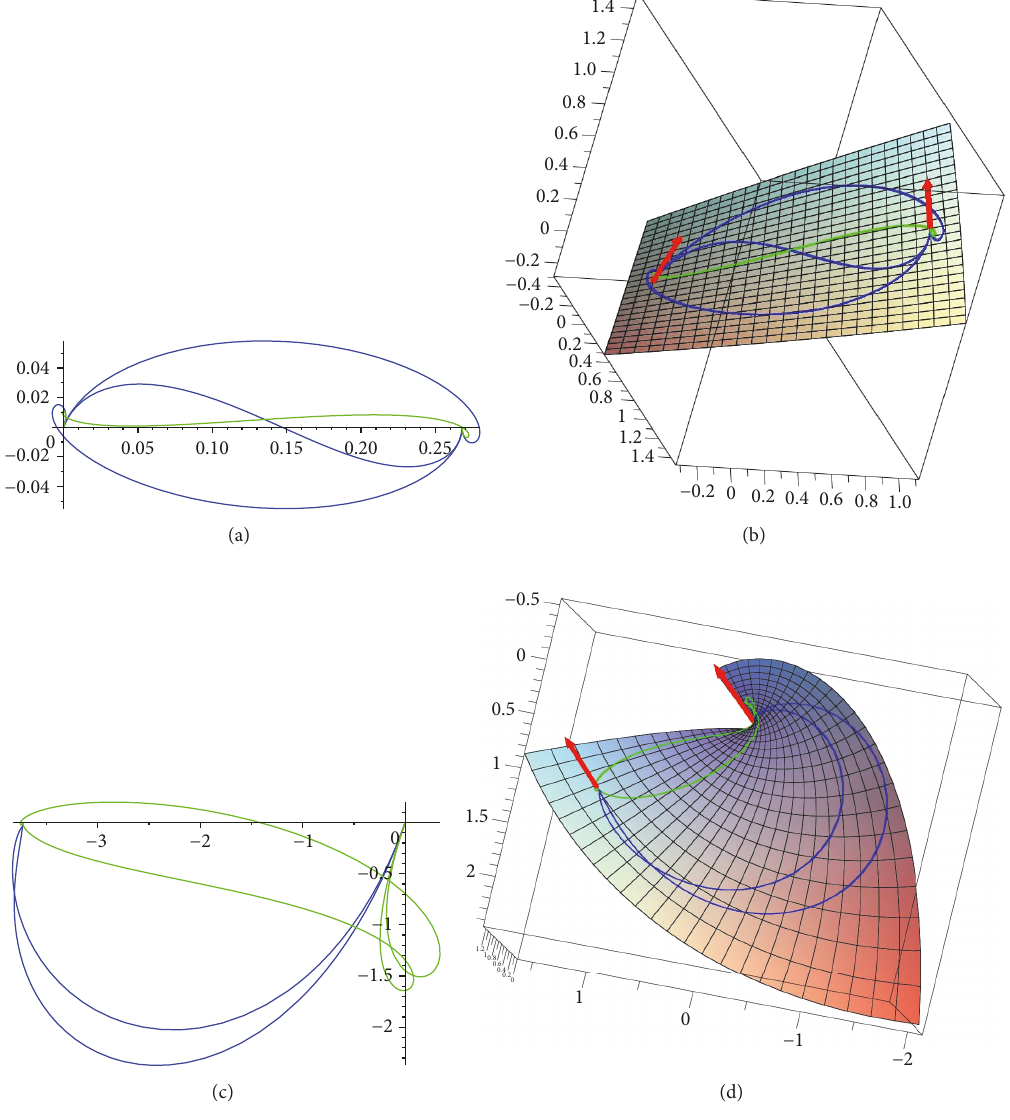
Figure 4: The s-Enneper surfaces and interpolants that satisfy 𝐻 1 𝐶 in Example 15: (a) four planar interpolants when 𝑢 0 = 2 − √3 and 𝜆 = (48 + 27√3)/26 ; (b) four interpolants satisfying 𝐻 1 𝜆 = −(48 + 27√3)/26 ; (d) four interpolants satisfying 𝐻 1